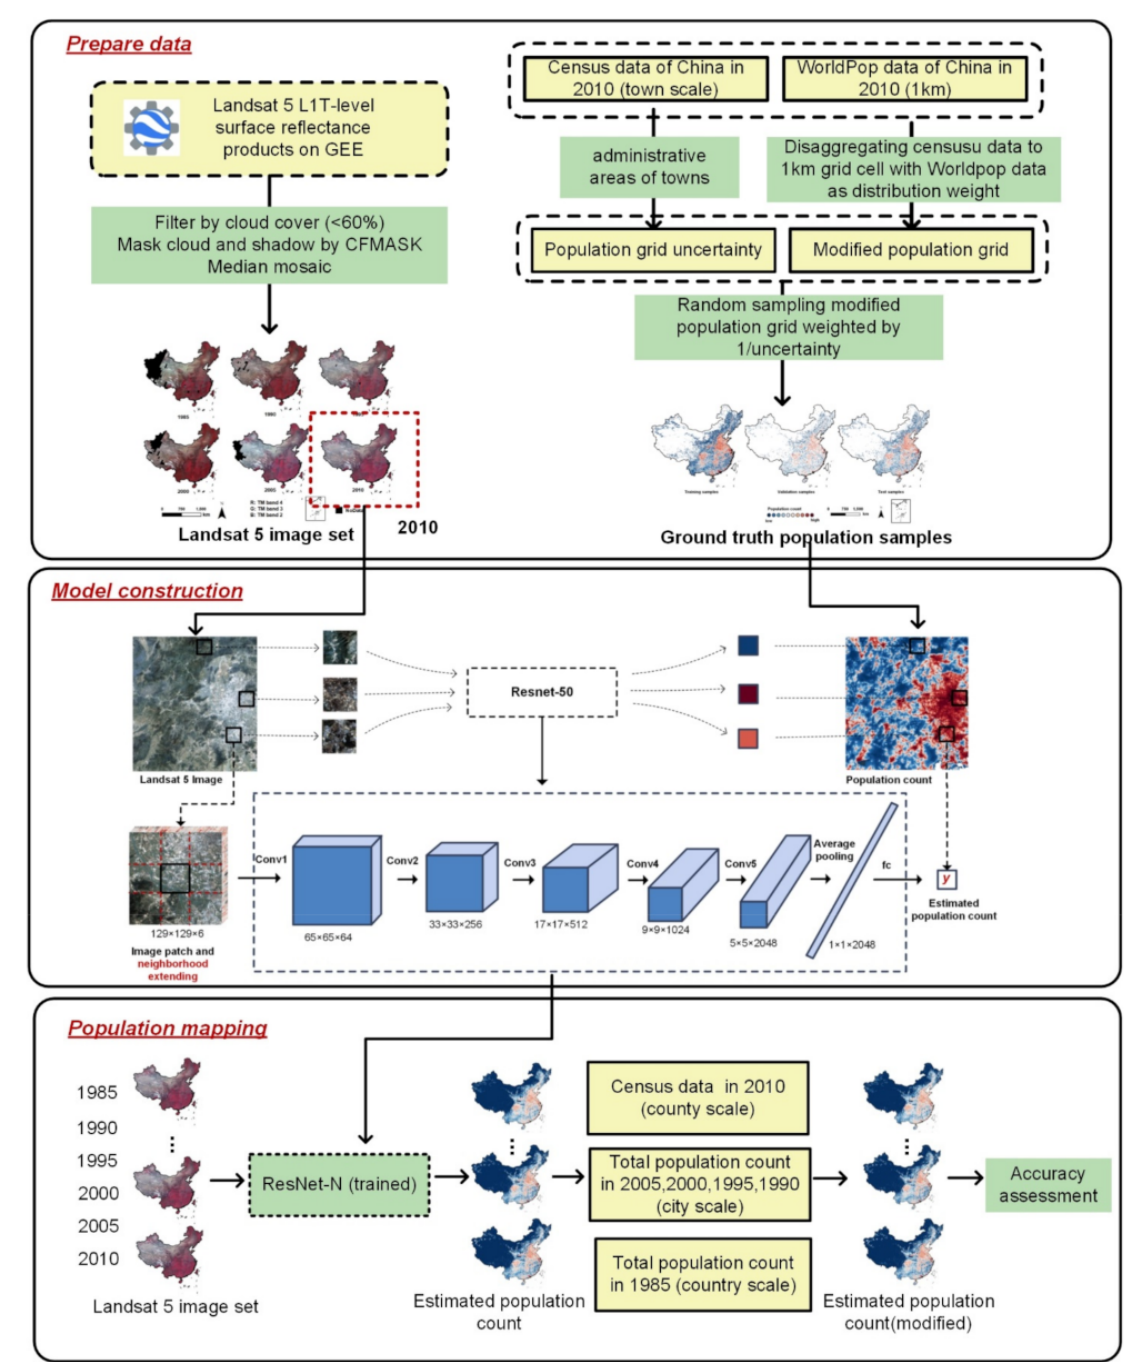
Figure 1. The flowchart of the proposed framework for mapping population distribution of China by integrating the ResNet-N model and Landsat-5 images from